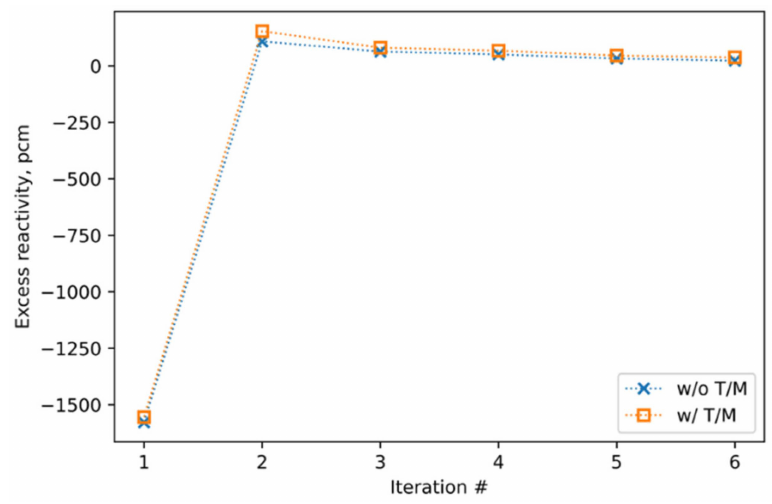
Figure 7. Comparison of excess reactivity